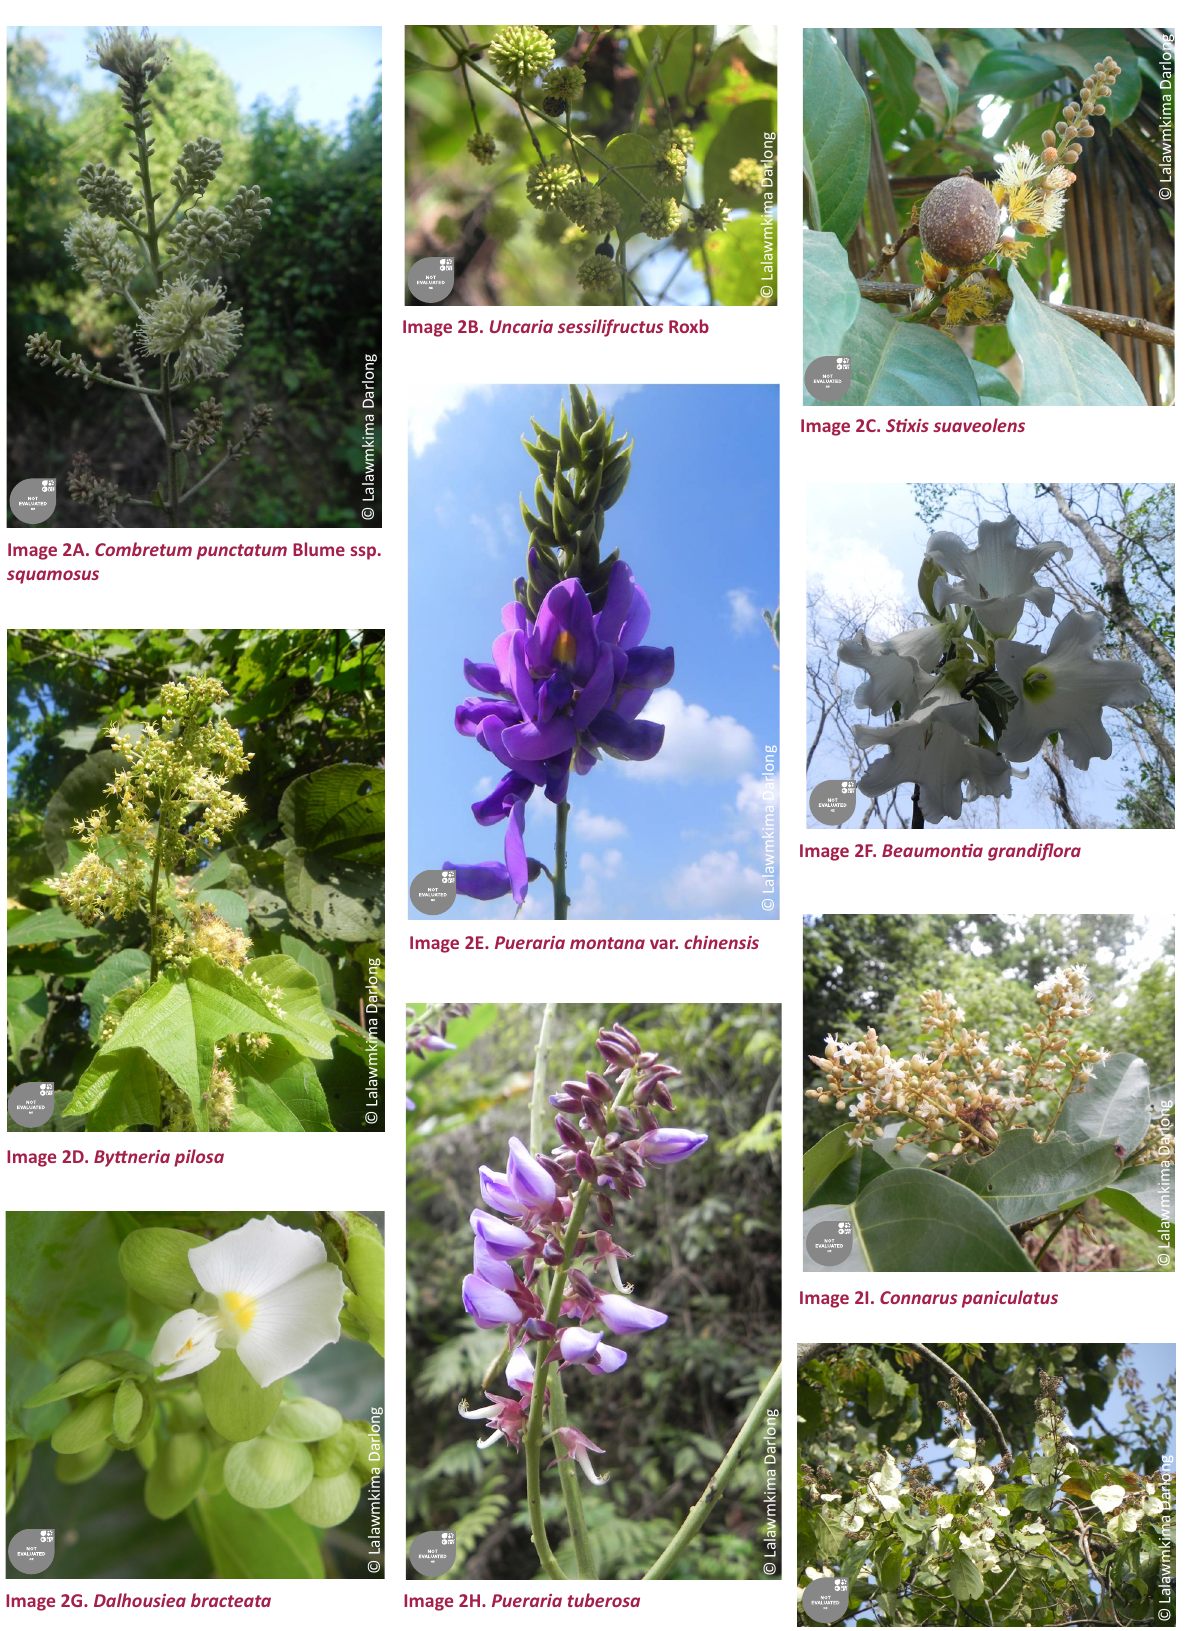
Image 2J. Combretum